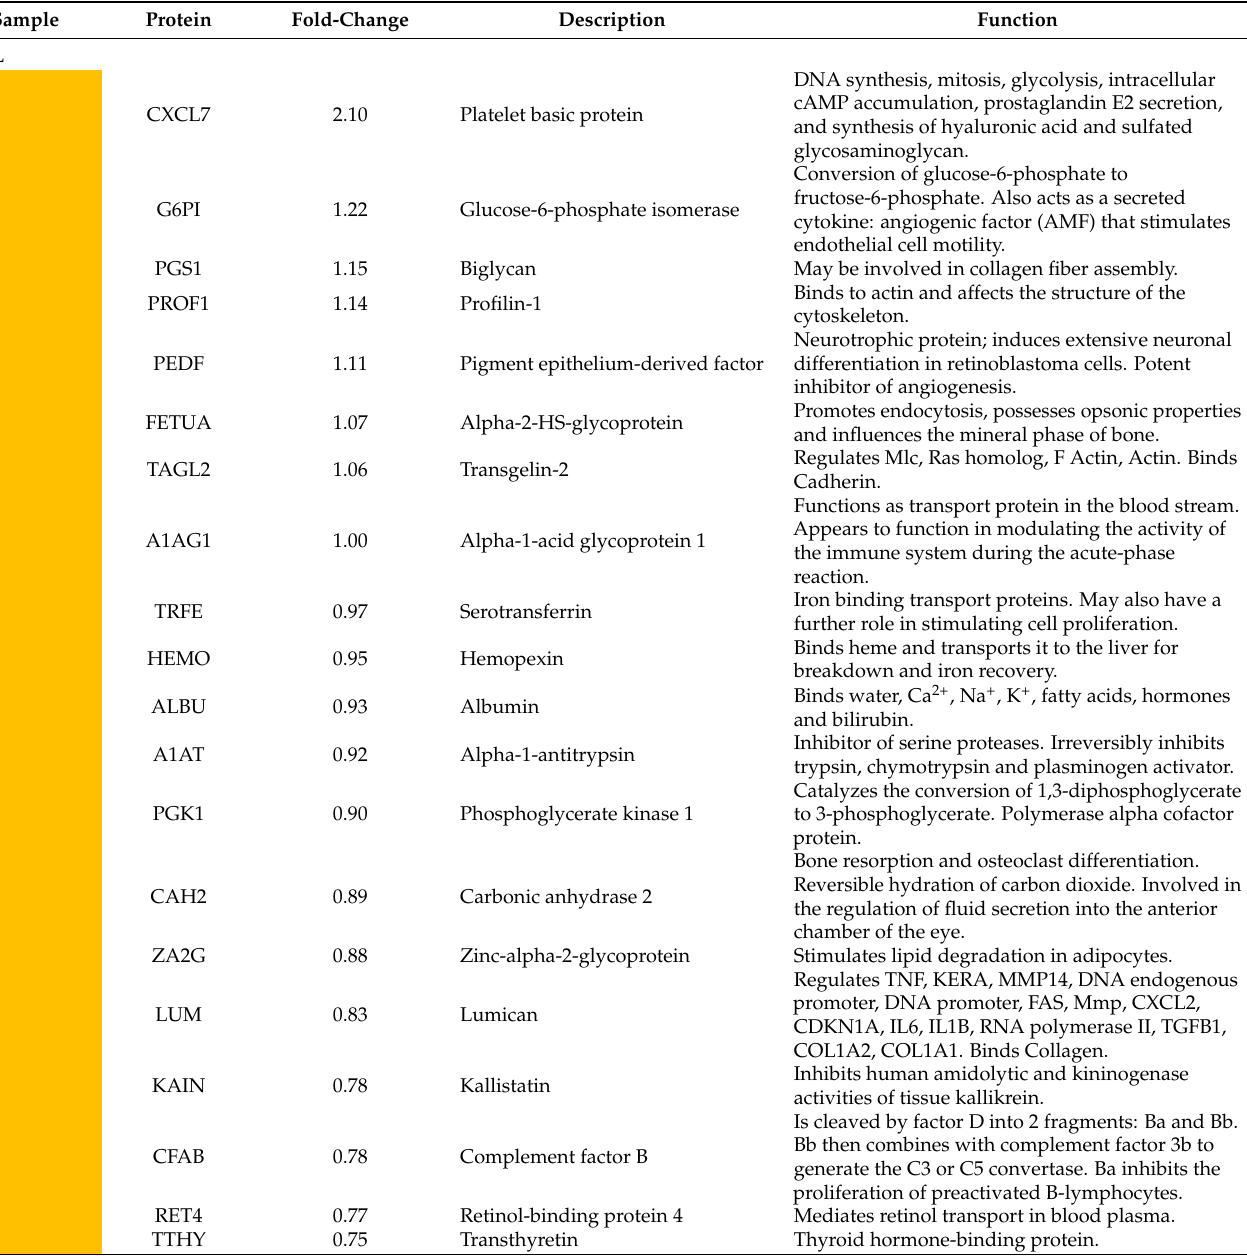
Table A2. Top-20 proteins enriched in HPL. According to the log2 fold-change (relative to the add-back of TSEC-EVs and TSEC soluble fractions) of proteins, the 20 most upregulated targets for each sample are compiled. Function descriptions were extracted and modified from the Uniprot database